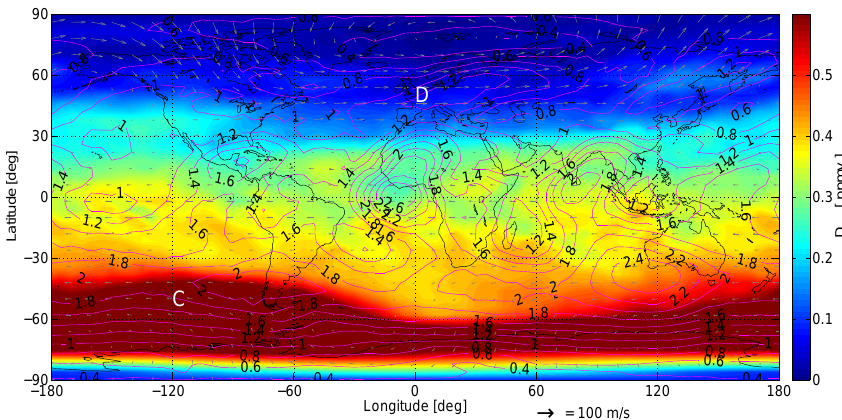
Figure 7d. Same to Fig. 7a with simulation data from December. The effects in Regions C and D are discussed in Sects. 6.2 and 6.3.